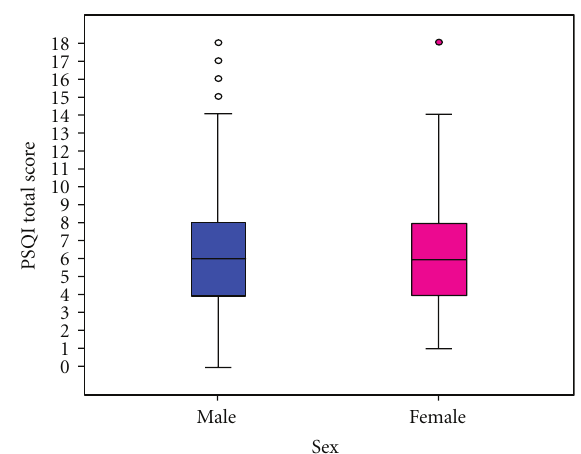
Figure 2: Distribution of Pittsburgh Sleep Quality Index score by